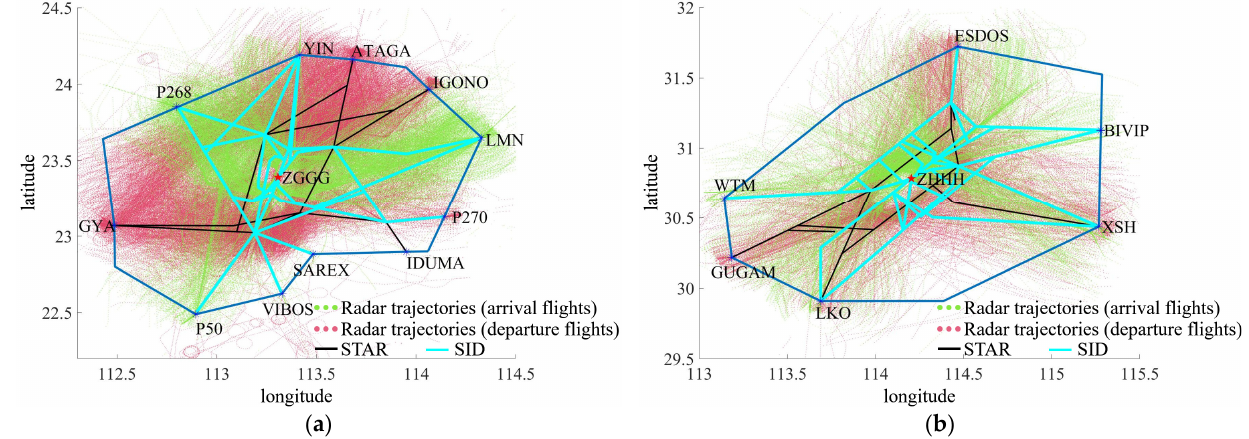
Figure 2. Comparison between radar trajectories and flight procedures. ( a ) ZGGG, ( b ) ZHHH. Trajectory clustering is based on the selection of distance calculation methods to Calculation of the Fr é chet distance is as follows: For the trajectory P composed of p trajectory points and the trajectory Q composed of q trajectory points, σ ( P ) and σ ( Q ) represent the sequential set of trajectory points of the two trajectories respectively,